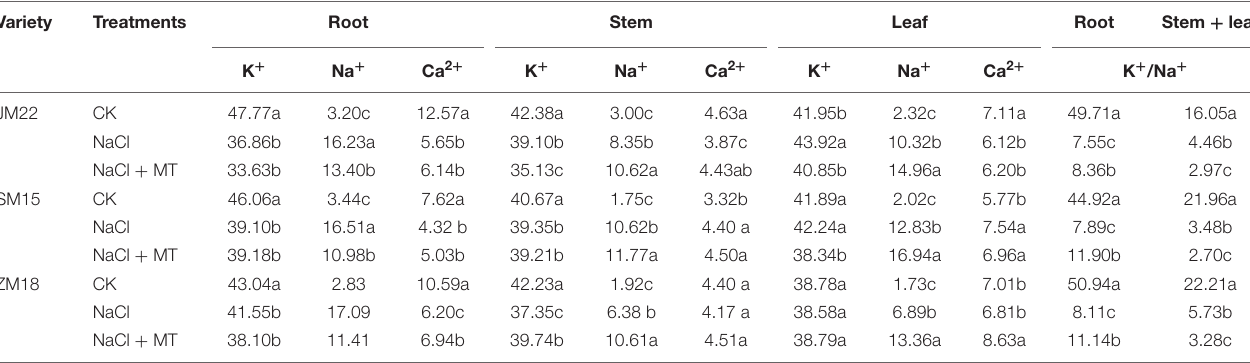
TABLE 4 | Effects of MT on K + , Na + , Ca 2 + , [K + ]/[Na + ] in root, stem, and leaf of wheat. Variety